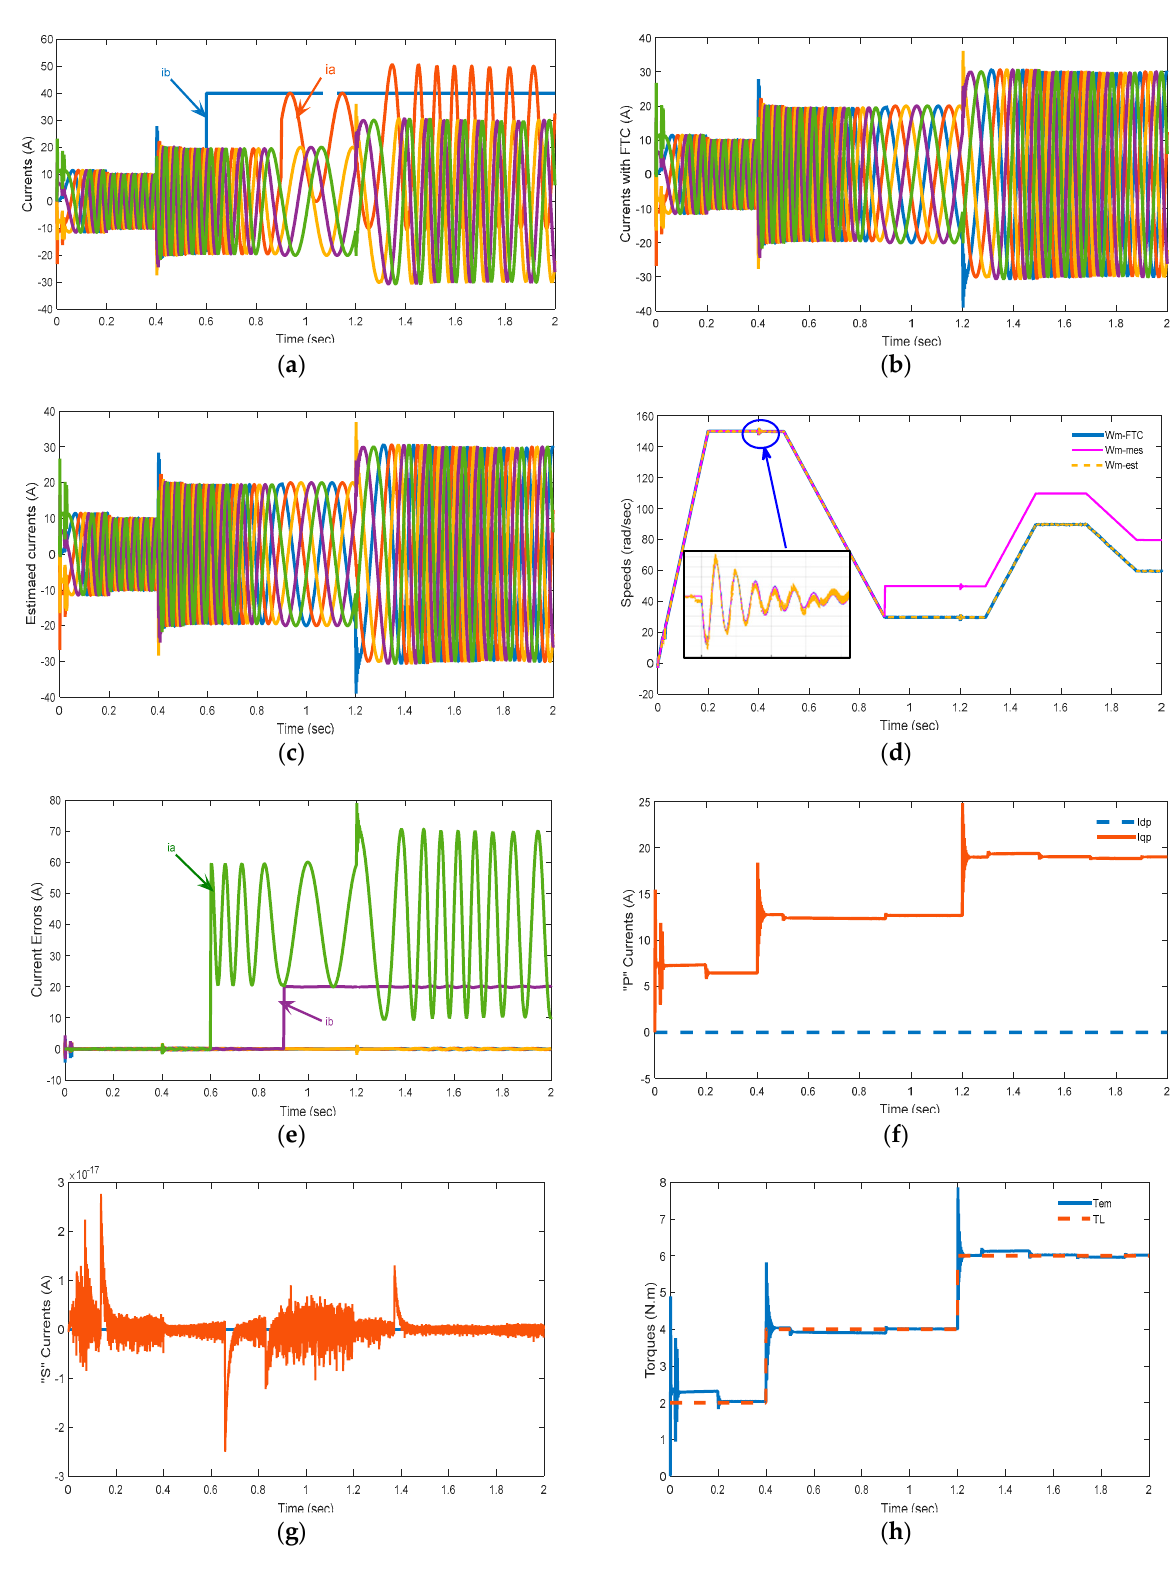
Figure 9. 5P-PMSM performance with speed and current sensor faults: ( a ) currents responses with fault application; ( b ) currents responses with FTC strategy application; ( c ) estimated currents; ( d ) speed responses with load torque and speed sensor; ( e ) stator current errors; ( f ) primary current responses; ( g ) secondary current responses; ( h ) electromagnetic and load torques.